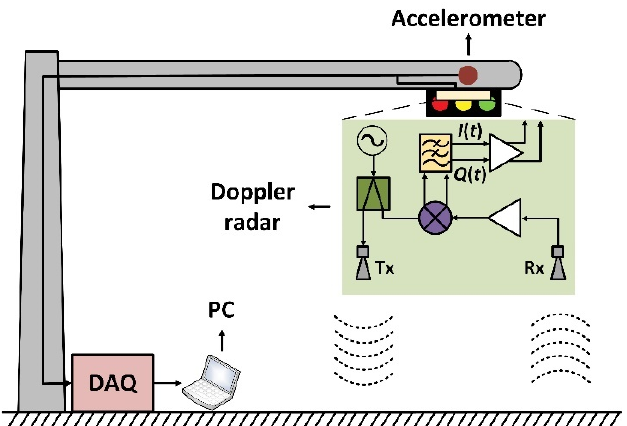
Figure 1. Block diagram for the structural health monitoring of a traffic signal structure using a Doppler radar.